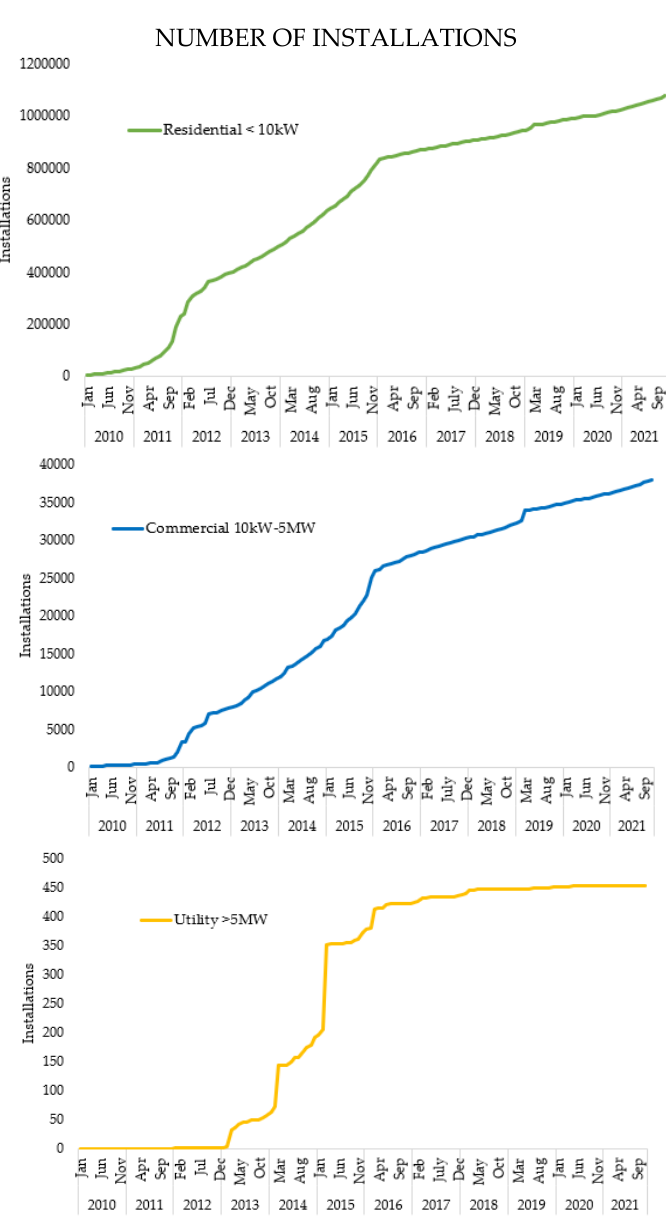
Figure 2. Monthly cumulative number of installations of solar PV by sector: residential (green), commercial (blue), and utility (orange) from January 2010 to November 2021. Data from [27].